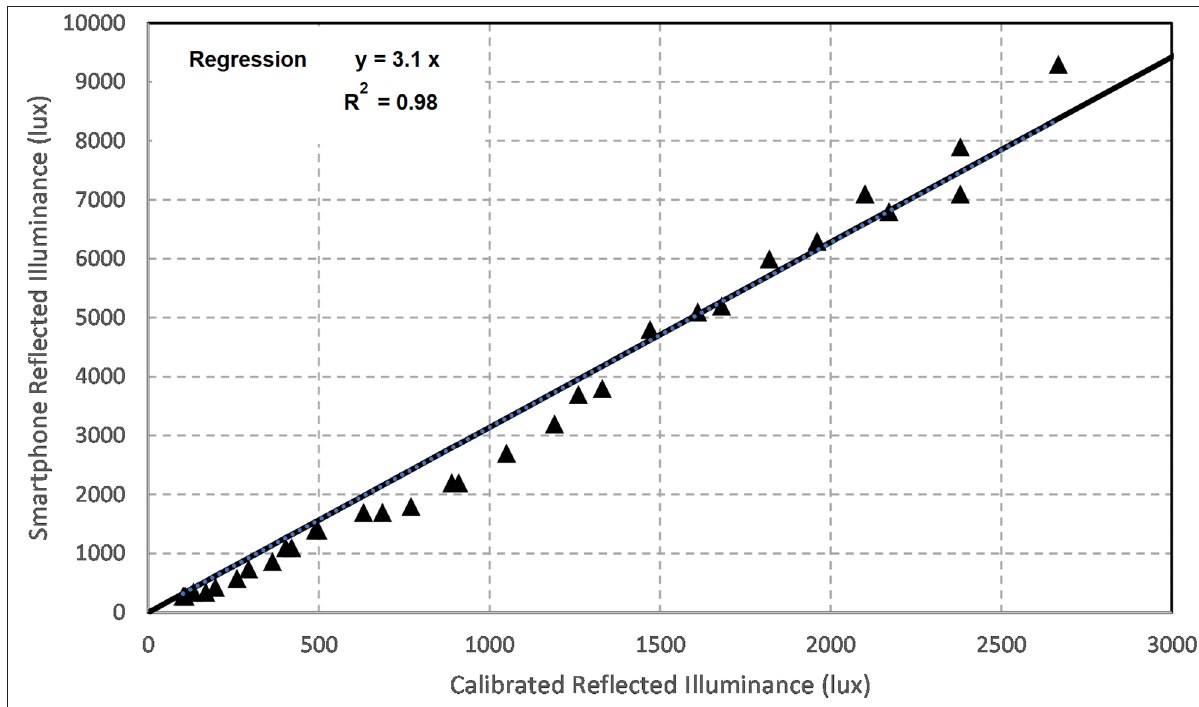
Figure 3: Data for Galactica ( triangle ) with linear regression forced to a 0 lx y-intercept to avoid an unphysical, negative illuminance as the